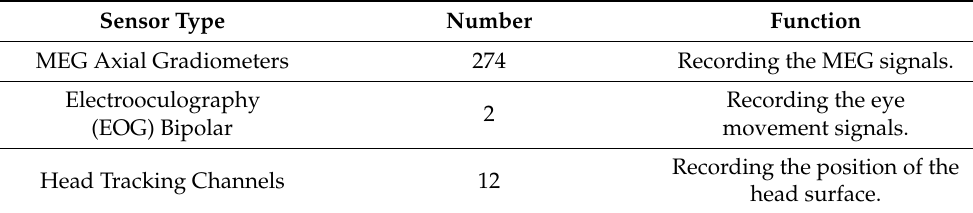
Figure 1. The distribution for the sensors of the SQUID magnetoencephalography (MEG) system. The figure is drawn with Brainstorm. The yellow blocks indicate the MEG Axial Gradiometers. The blue block indicates the horizontal electrooculogram (EOG) bipolar. The red block indicates the vertical EOG bipolar. Table 1. Sensors employed in the experiment.